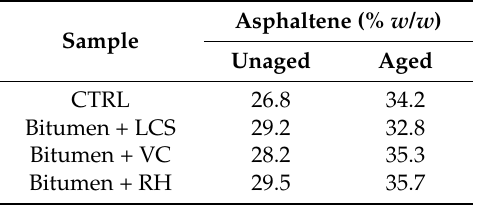
Table 1. The weight percentages of asphaltene fraction obtained from crude bitumen (CTRL) and bitumen modified with LCS, VC and RH additives, both unaged and subjected to artificial